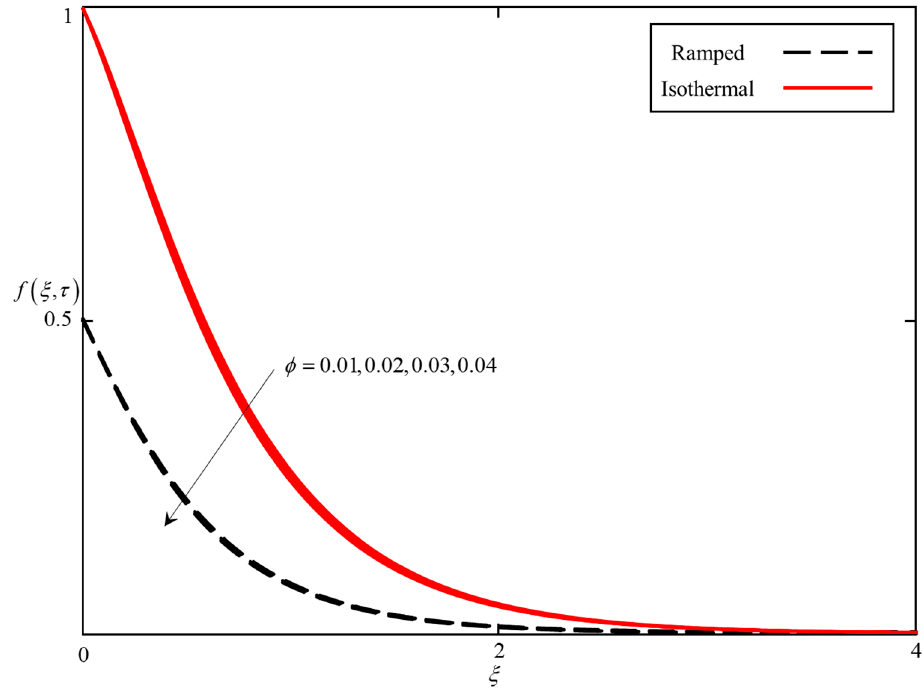
Figure 9. Consequence of φ on the velocity field, when α = 0.5, β = 0.04, λ 1 = 0.5, λ 2 = 0.5, M = 0.5, K = 0.5 Pr = 21, and Gr =